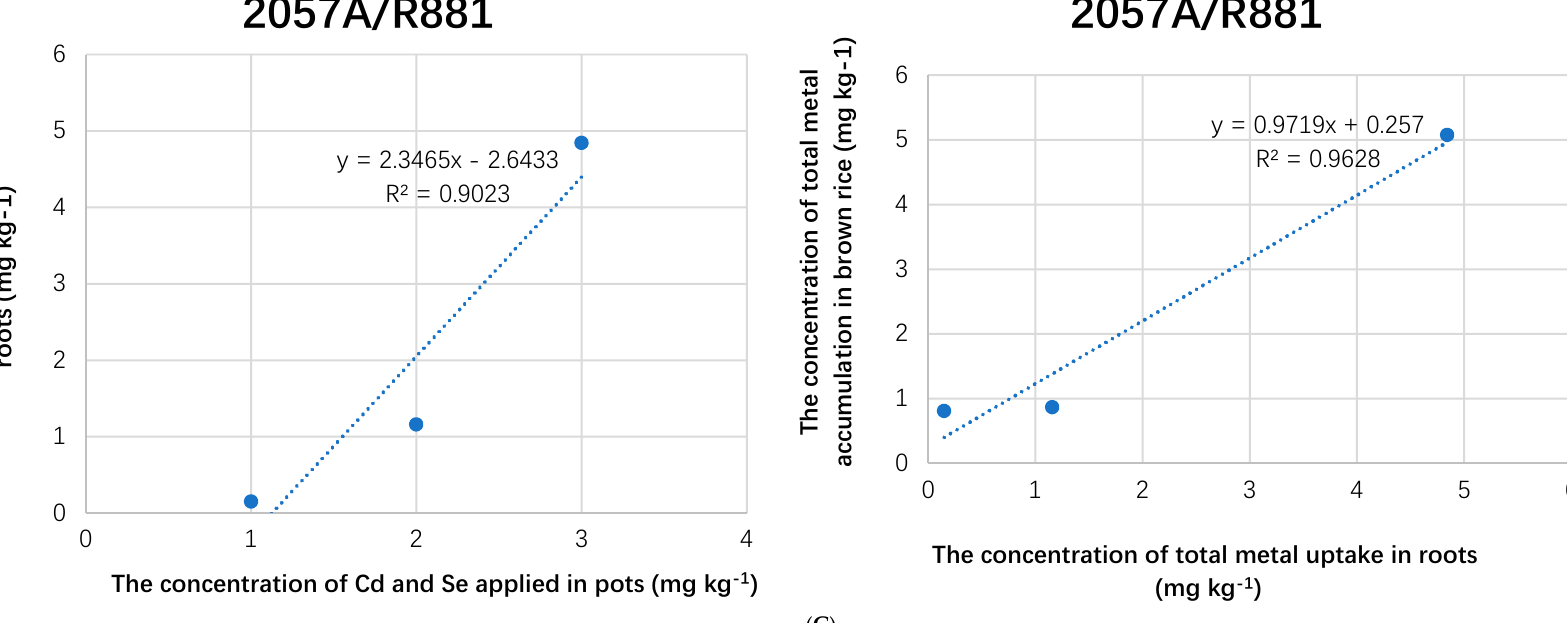
Figure 2. ( A ) The linear association between the different components of Se-enriched rice (5097A/R2035); ( B ) The linear association between the different components of non-Se-enriched rice (GangYou 725); ( C ) The linear association between the different components of Se-enriched rice (2057A/R881).